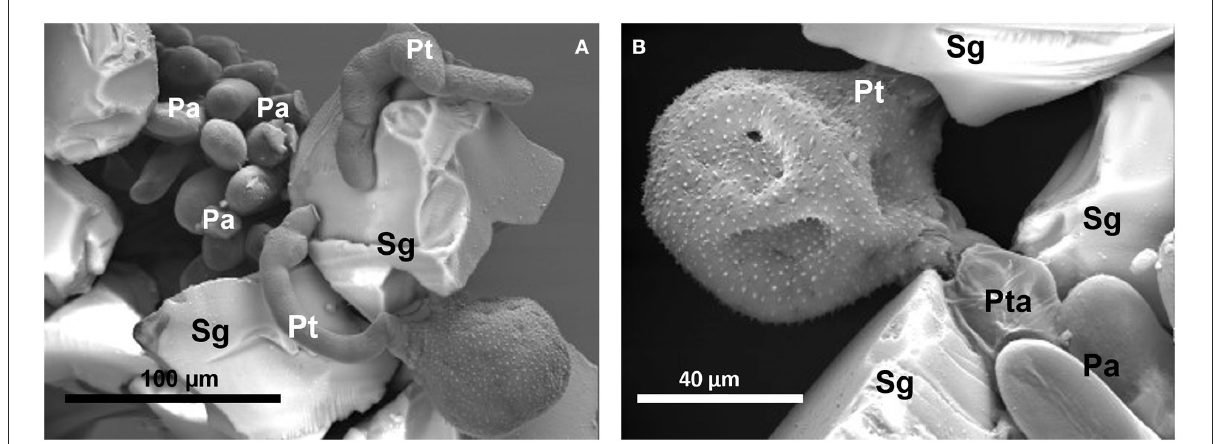
FIGURE4 Scanning electron micrographs of the germination of Crocus pollen on the stigma papillae (Pa) sprinkled with Silica gel scales (Sg) before pollination. (A) Pollen grain with two tubes (Pt) embracing a Silica scale close to the papillae. (B) Pollen grain with two tubes, the emerging one is on a Silica scale and the other is closest to the papillae but its apex is flattened on the scale.